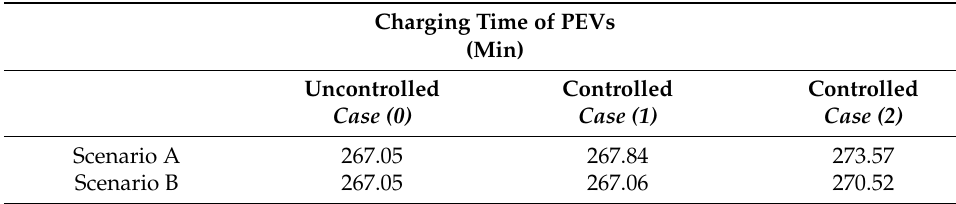
Table 4. Charging time of the PEVs for different arrival time scenarios.